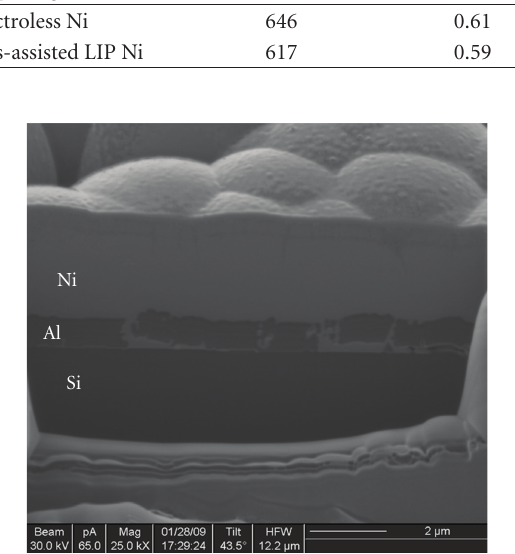
Figure 3: Focused ion beam (FIB) cross-section image of the rear contact of a test cell. Unwanted electroless Ni plating at the rear point contact has displaced some of the Al, contacting the Si surface and increasing the contact resistance